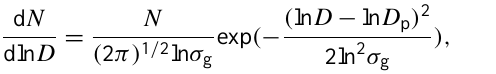
Coarse dust Coarse sea